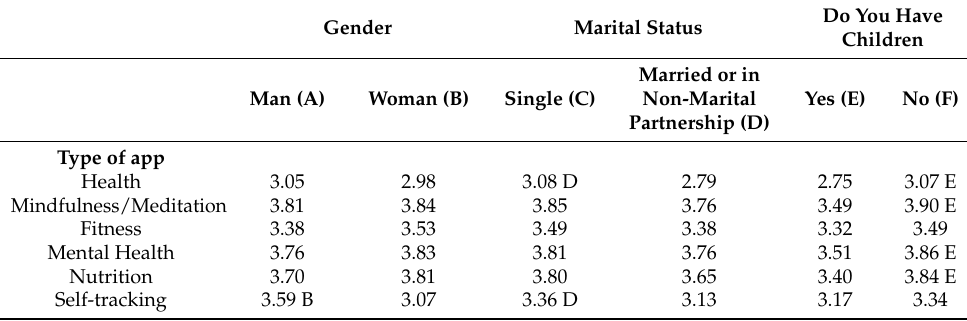
Table 3. Health and wellbeing apps mean perception of usage (1–5).